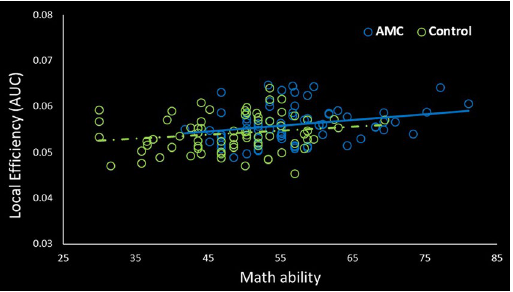
Figure 2. Relationship between math ability and local efficiency in right fusiform gyrus. In the AMC group, significant positive relationship was observed ( r = 0.26, p = 0.03), while no correlation was found in the control group ( r = 0.18, p > 0.05).